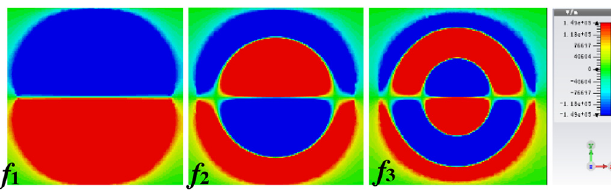
Fig. 3. Electric fi eld component E z at z = 3.62 m m corresponding to different absorption peaks when the phase is zero.